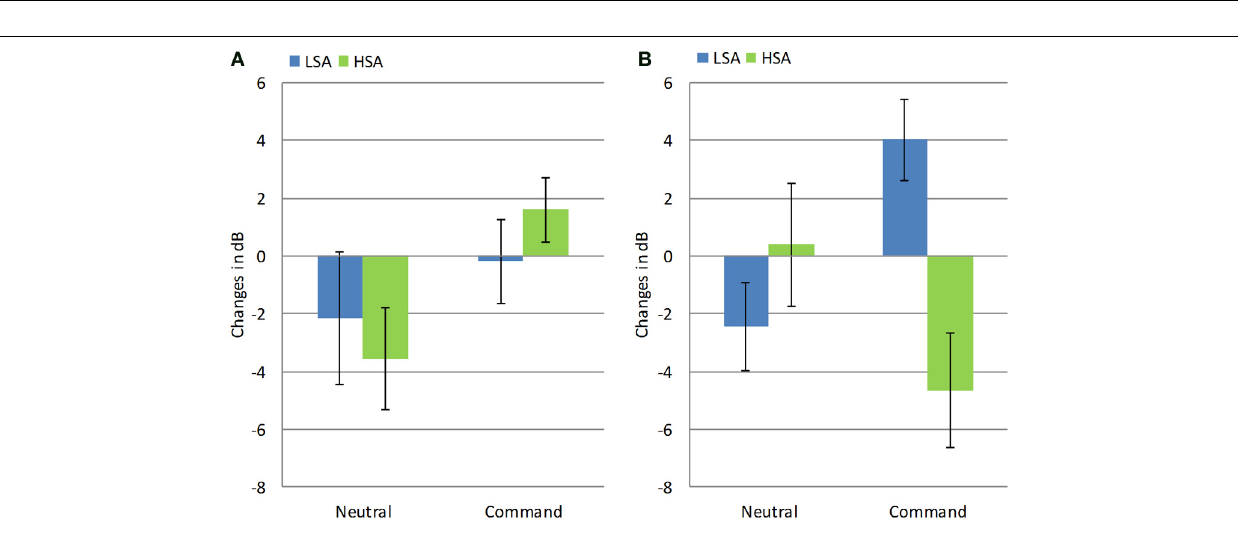
FIGURE 3 | Changes in vocal intensity following exclusion in high and low socially anxious women (A) and men (B). Error bars represent standard errors of the